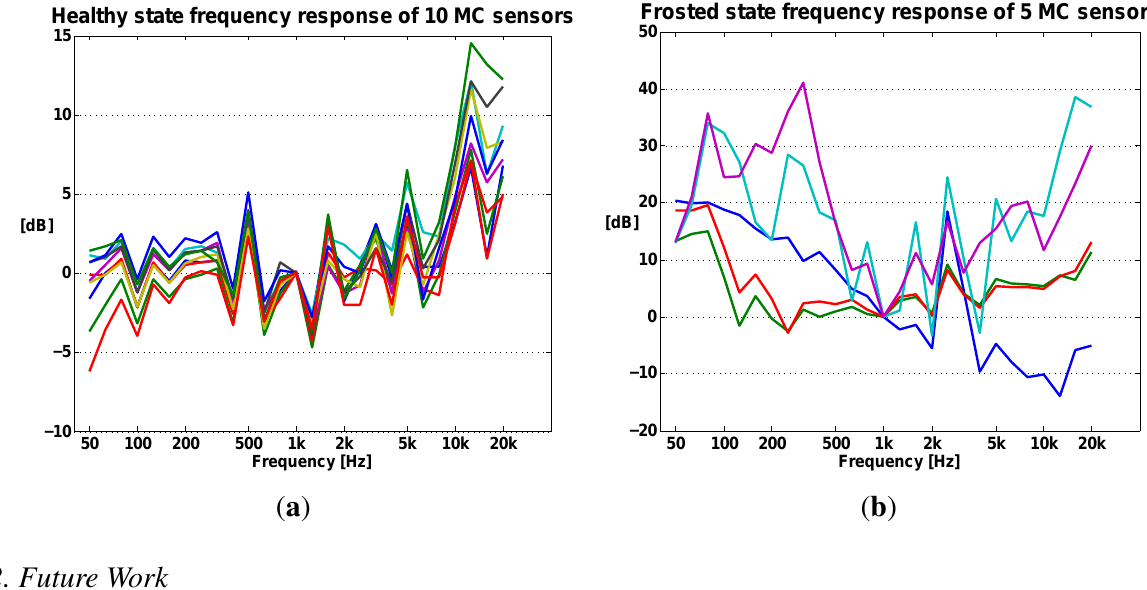
Figure 16. Plots a and b show the frequency response of MC sensors when new ( a ) and when exposed to frosting ( b ) in a weather chamber. The measured frequency response of healthy MC sensors, while not ideally flat, is reproducible. However, the same capsules, when frosted, output a non-reproducible frequency response, precluding the use of the frequency response to characterize a failure condition. The frequency response plots presented here were obtained using a high-end acoustic measurement chain. ( a ) Frequency response of healthy microphone capsules; ( b ) Frequency response of frosted microphone